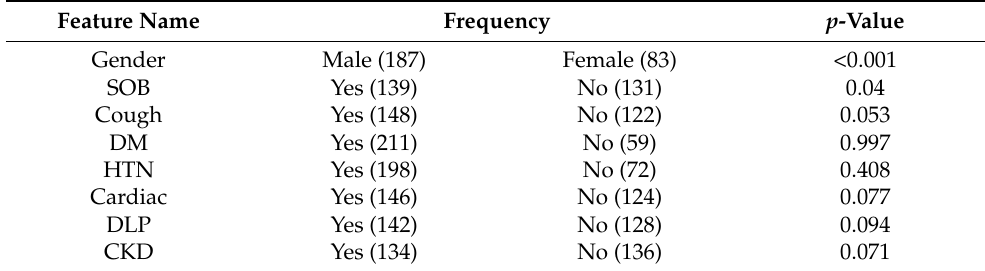
Table 3. Statistical analysis of the categorical